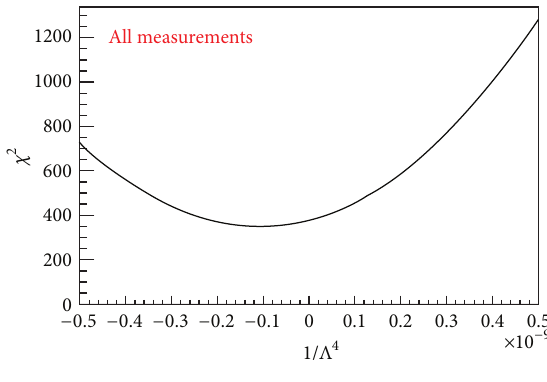
Figure 1: A minimum in the 𝜒 2 fit with 𝑃 = 1/Λ 4